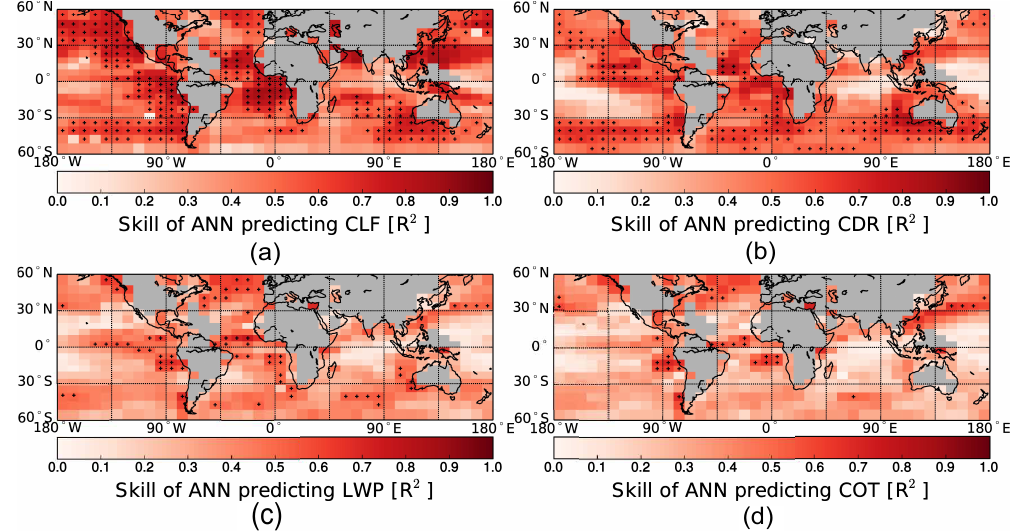
Figure 3. Global patterns of ANN skill ( R 2 ) predicting (a) cloud fraction, (b) cloud droplet effective radius, (c) cloud liquid water path and (d) cloud optical thickness. As only ANNs with R 2 > 0 . 5 and rel. RMSE less than its global average are used to compute the sensitivities, these are marked by a “ + ”.